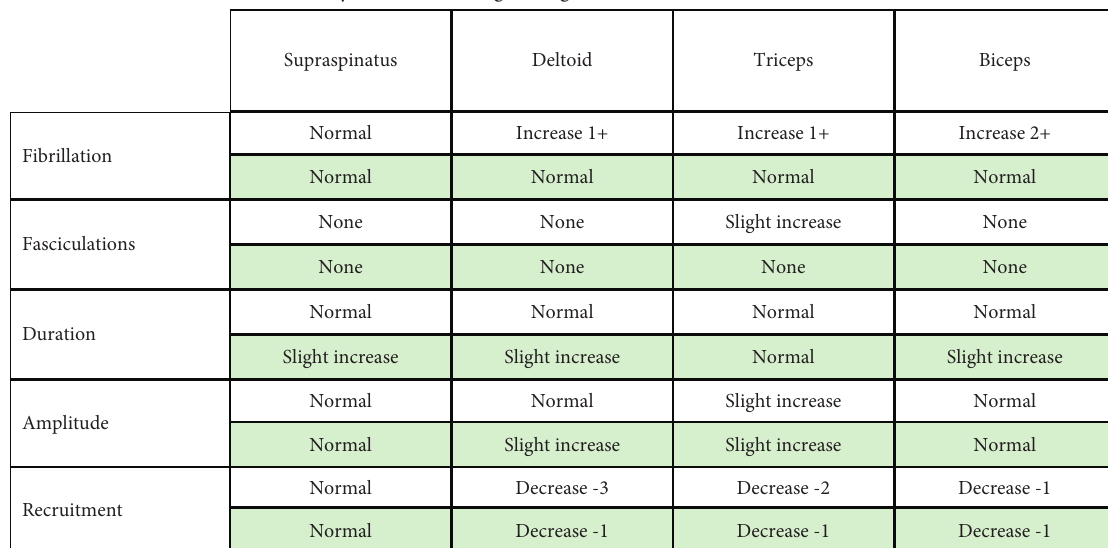
Table 2: Summary of EMG findings of right limb before and after IVIG treatment.